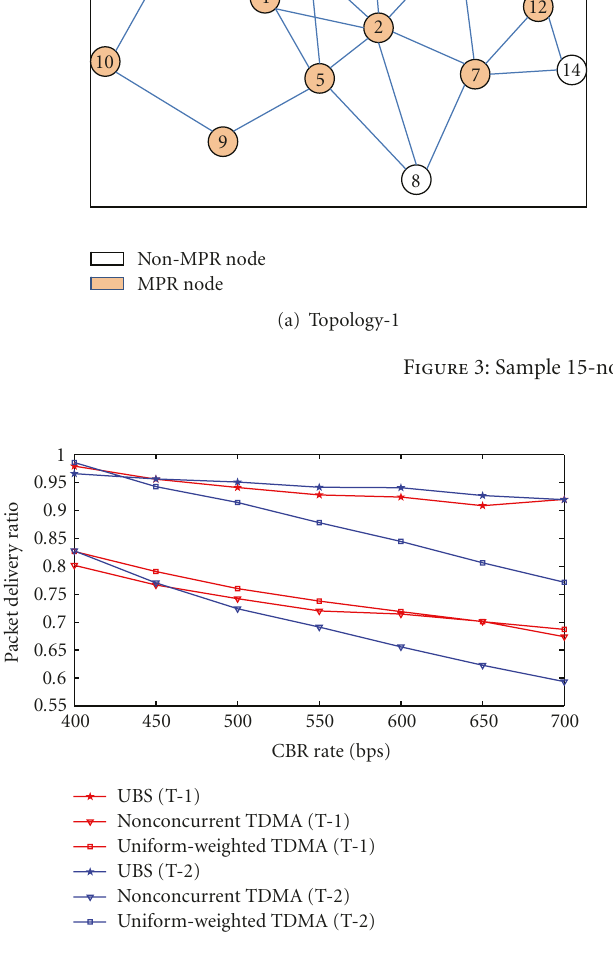
Figure 4: Packet-delivery ratio on two di ff erent network topologies (T-1 and